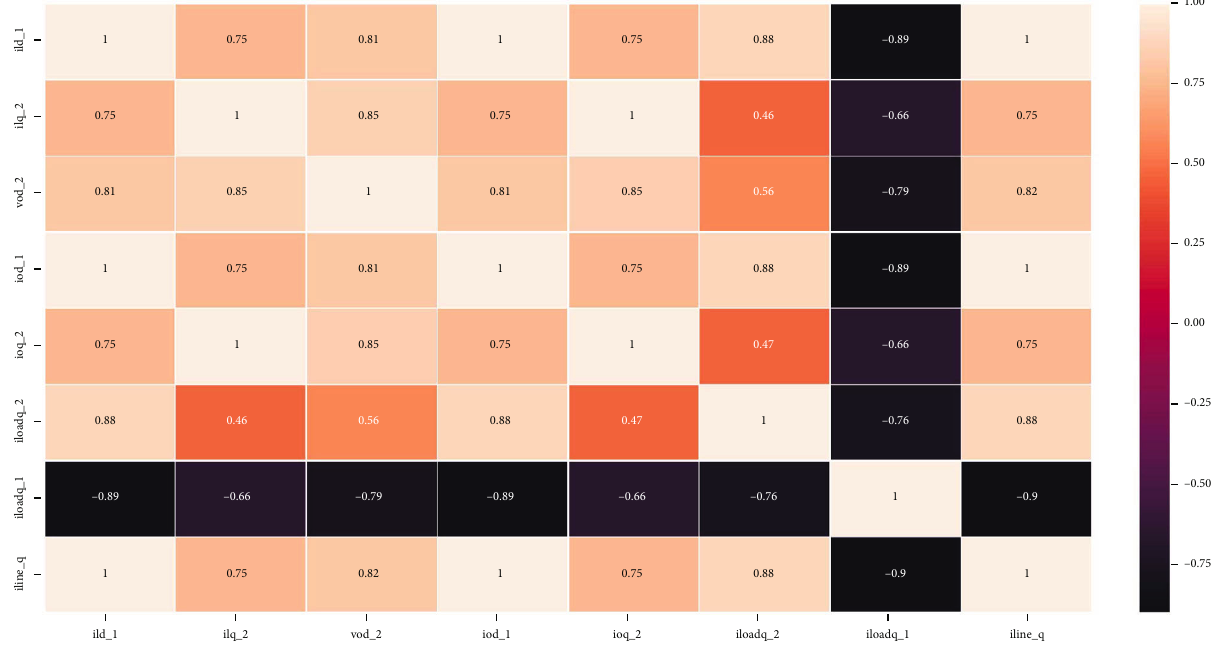
Figure 21: Heatmap of [4] state